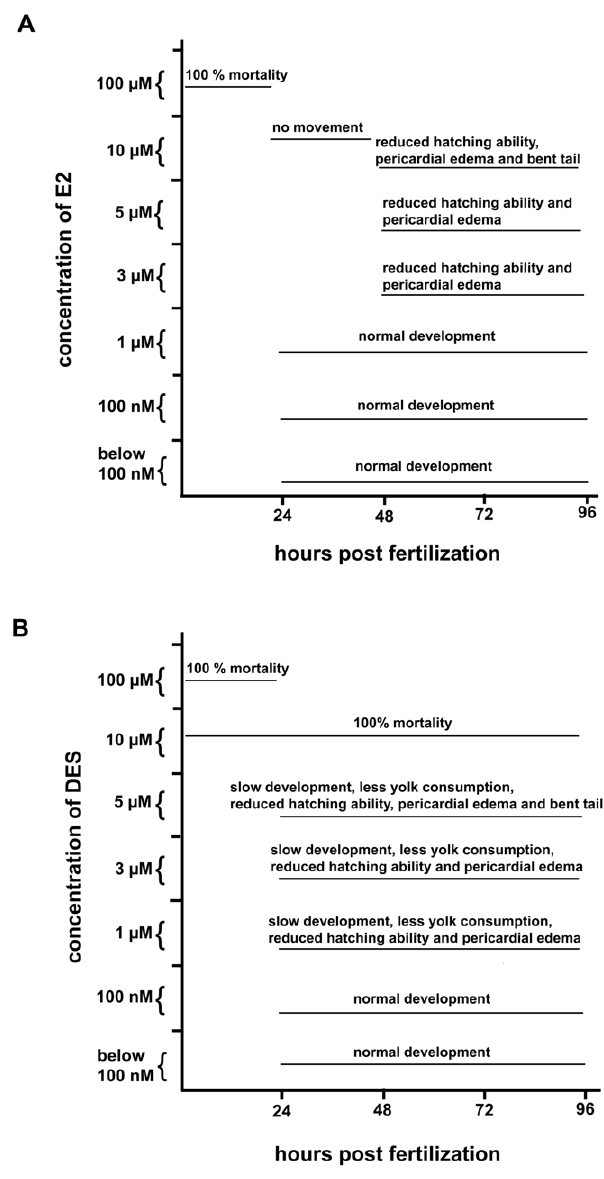
Figure 2. Effects of natural or synthetic ligand concentrations in early-life stages. The ligand dependent effects of different concentrations of E2 (A) or DES (B) during embryogenesis and early larval stages are shown. Following exposure of 7 hpf embryos the mortality rate and the visible phenotypes were monitored. Concentra- tion of the ligands is plotted against the stage of